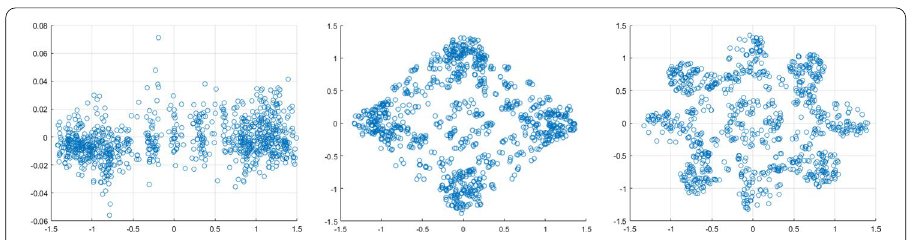
Fig. 7 Constellation diagram of the generated interference